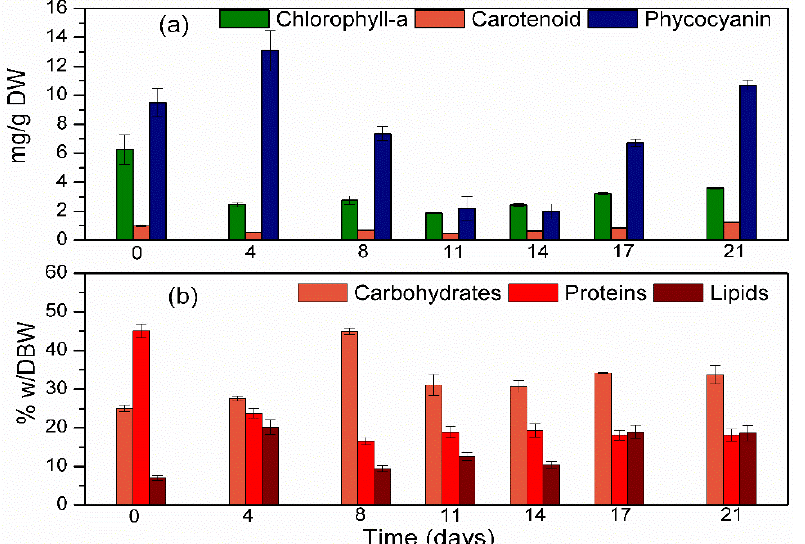
Figure 5. ( a ) Pigments content and ( b ) carbohydrate, protein and lipid contents into total biomass applying photoperiod (16:8 h light:dark) during A. platensis cultivation in brewery wastewater with 1 g/L NaCl and 5 g/L NaHCO 3 . Data present mean values of duplicate experiments ± standard deviations.